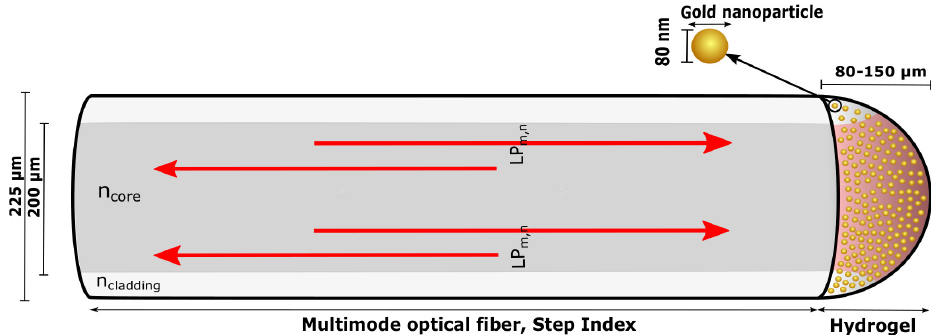
Figure 1. Illustration of the multimode (MM) OF with hydrogel containing gold nanoparticles (GNPs) immobilized on a fiber end face. Visible light is guided in the fiber core with the numerical aperture colored with red in the